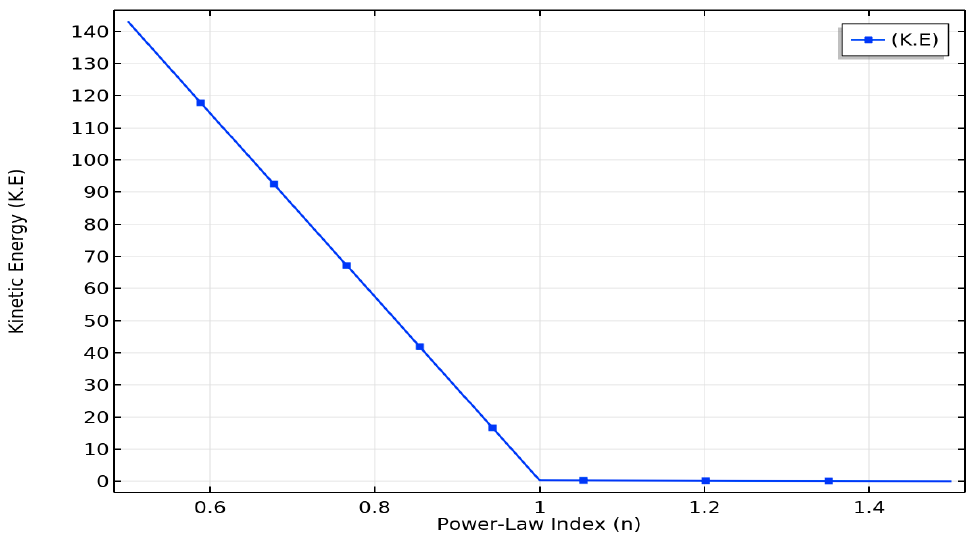
Figure 6. Graphical demonstration of variation in kinetic energy w.r.t power law index (𝑛) .